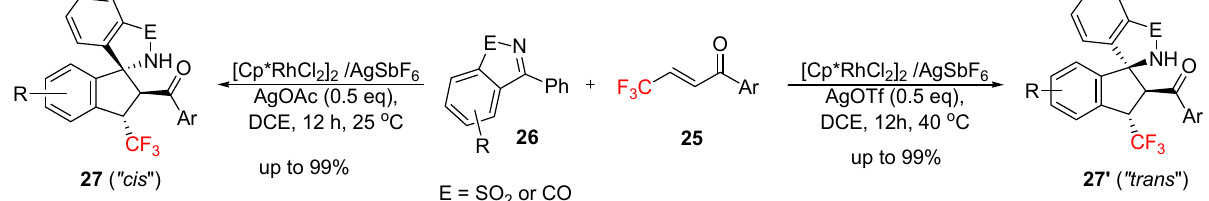
Scheme 19. Synthesis of 1-CF 3 -indanespirocycles 27 and 27 ′ by Rh(III)-catalyzed [3+2] annulation of β -CF 3 -enones 25 with cyclic- N -sulfonyl and N -acyl ketimines 26 .